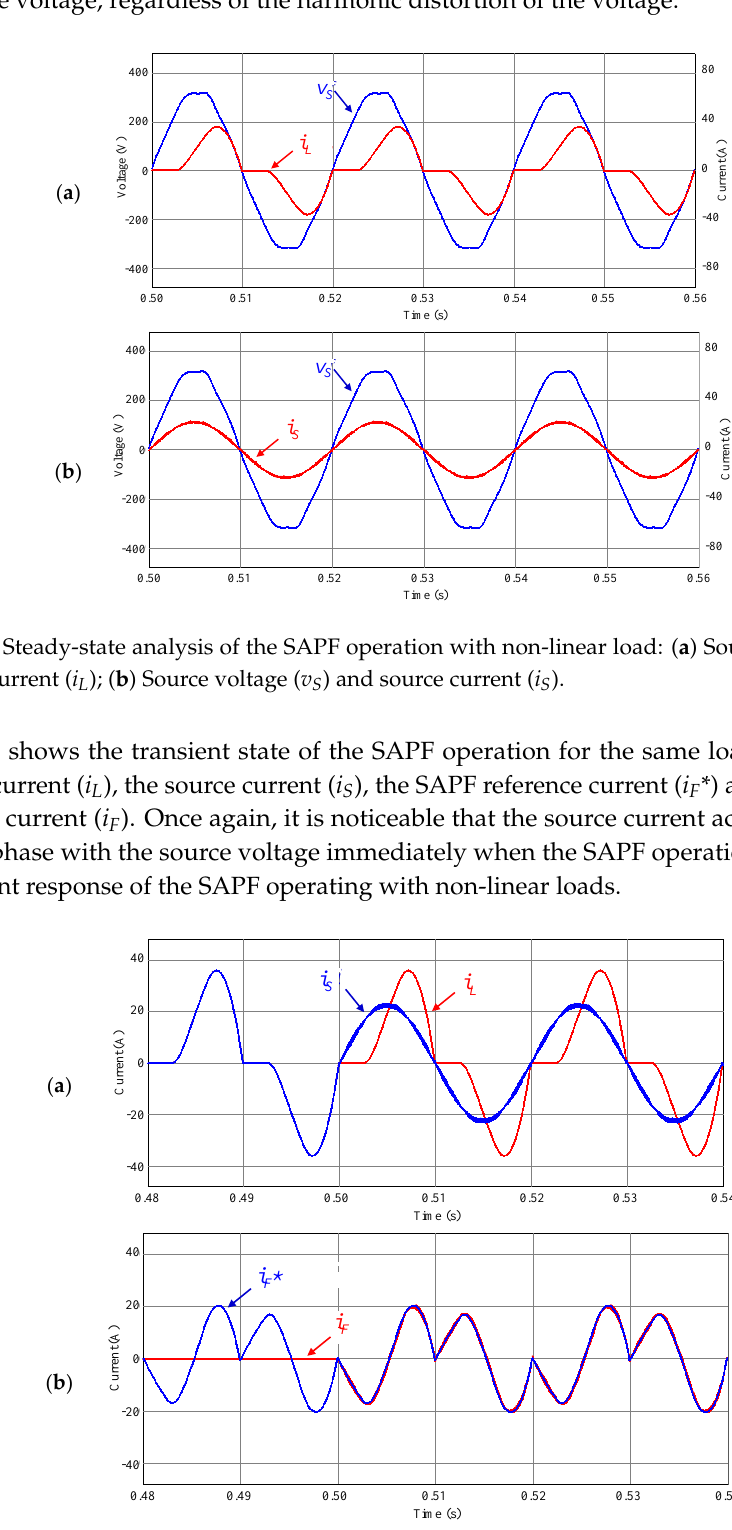
Figure 13. Transient analysis of the SAPF operation with non-linear load: ( a ) Load ( i L ) and source currents ( i S ); ( b ) SAPF reference ( i F *) and actual ( i F ) compensation current.